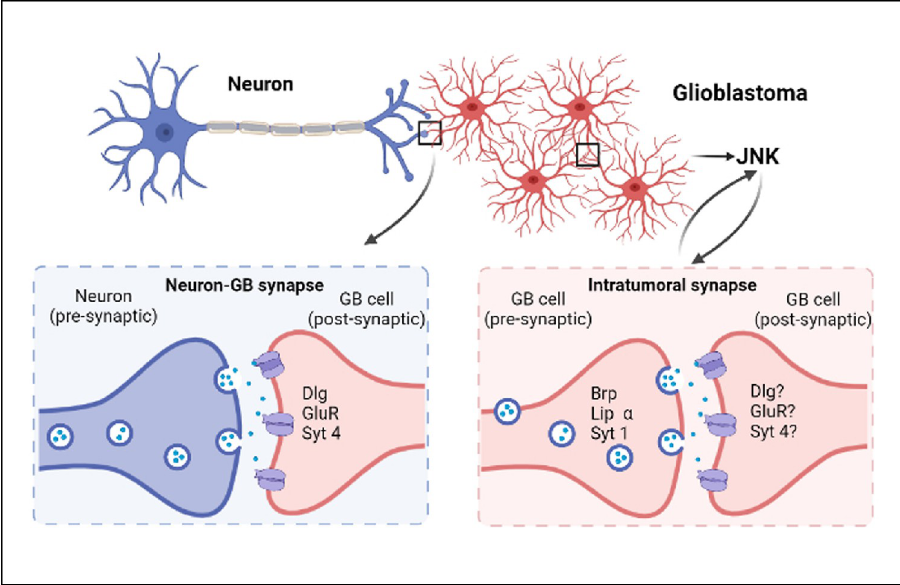
Fig 8. Summary. Schematic representation of neuron-GB synapse and intratumoral synapses. Bottom left, Neuron (blue) is the presynaptic component and GB cell (red) is the postsynaptic component. GB cells express postsynaptic genes dlg , GluR and Syt 4 . Bottom right, intratumoral synapses are formed between two GB cells (red), presynaptic GB cells express Brp , Lip α and Syt 1 . The other GB cells behave as postsynaptic, and have the same identity as in Neuron- GB synapses ( dlg , GluR and Syt 4)